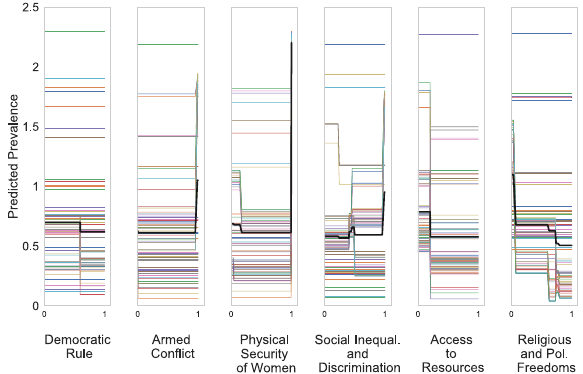
Fig. 7 Individual Conditional Expectation (ICE) plots to illustrate the non- linear effects of components on the best model ’ s predictions. Each coloured line is a country-year data point with some jitter applied. The thick black line is the average partial dependency of the component on the prevalence